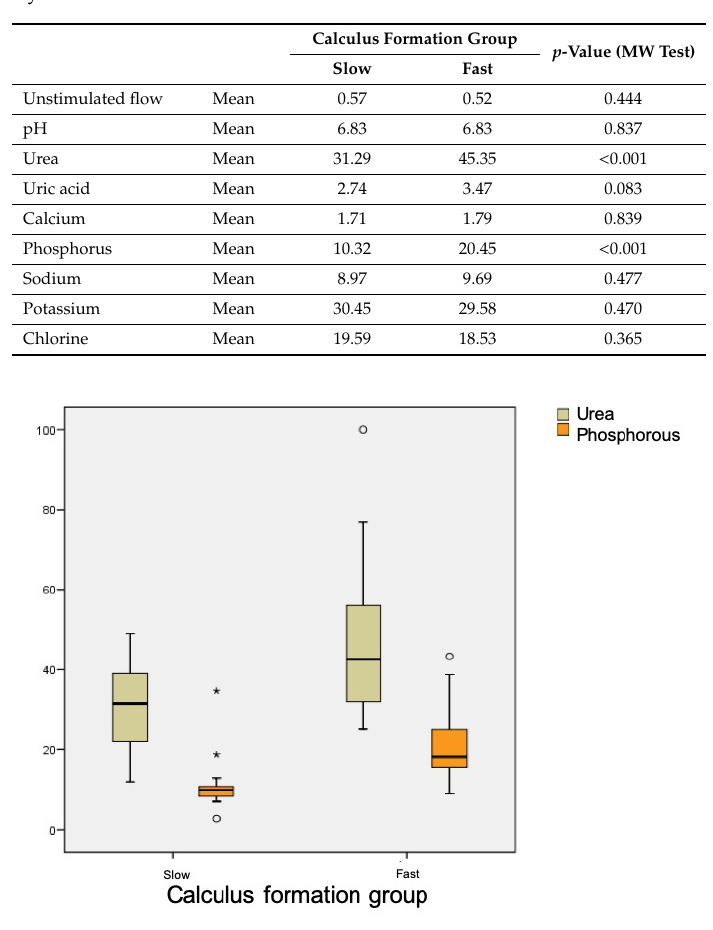
Figure 4. Distribution of urea and phosphorus in the two groups.